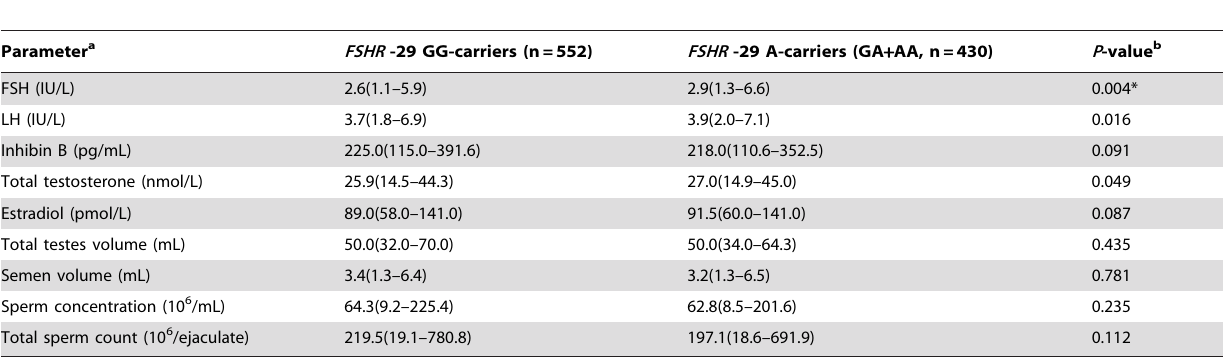
Table 3. Test results for the difference in estimated median values and distributions of the study parameters in the Baltic male cohort subgroups stratified based on the carrier status of the A-allele of FSHR -29G/A.